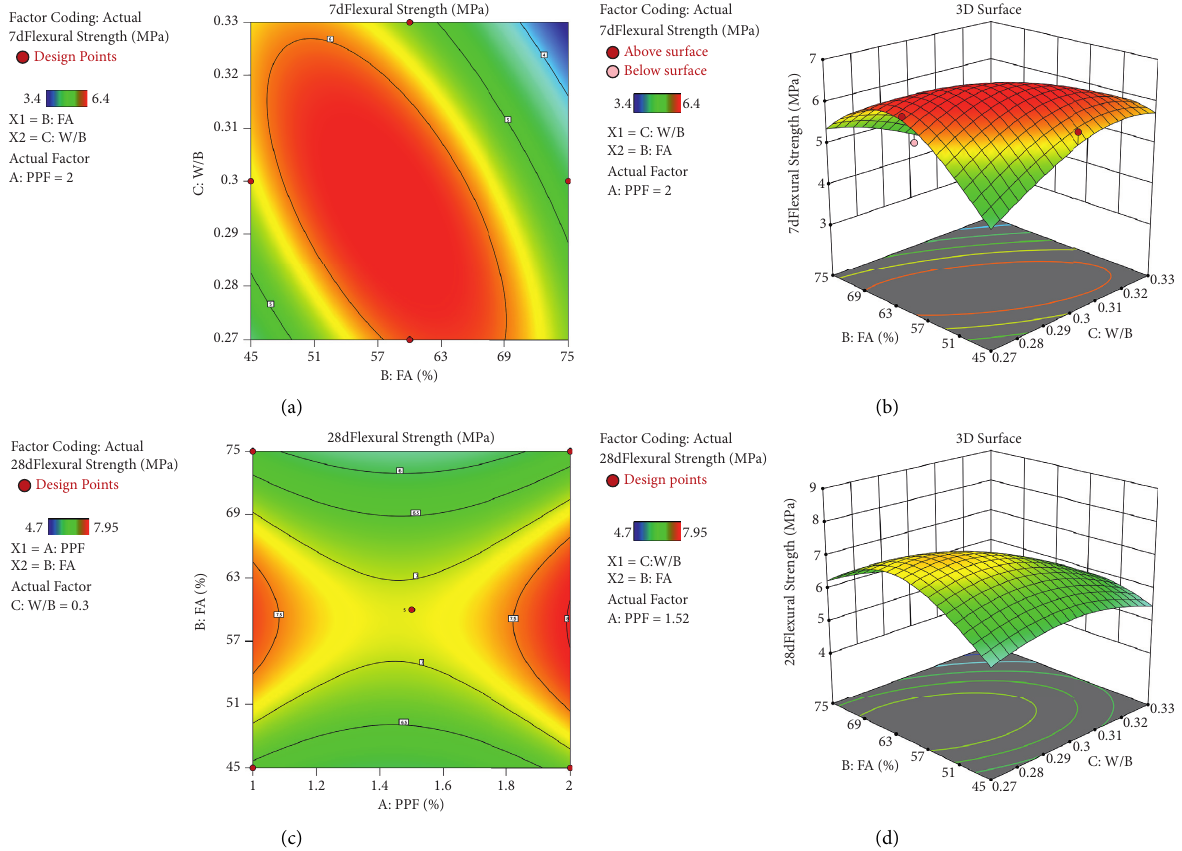
Figure 13: Contour plots. (a, b) 7 d flexural strength. (c, d) 28 d flexural